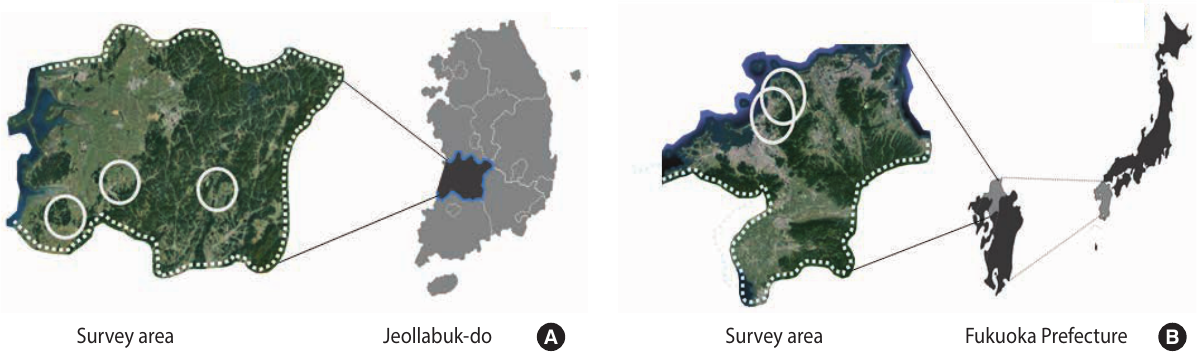
Figure 1. The surveyed areas consisted of 7 villages (3 regions-white open circles) in Jeollabuk-do in Korea (A) and 5 villages (2 regions-white open circles) in Fukuoka Prefecture in Japan (B). These areas were similar regarding agricultural characteristics, agricultural work environ- ment, and